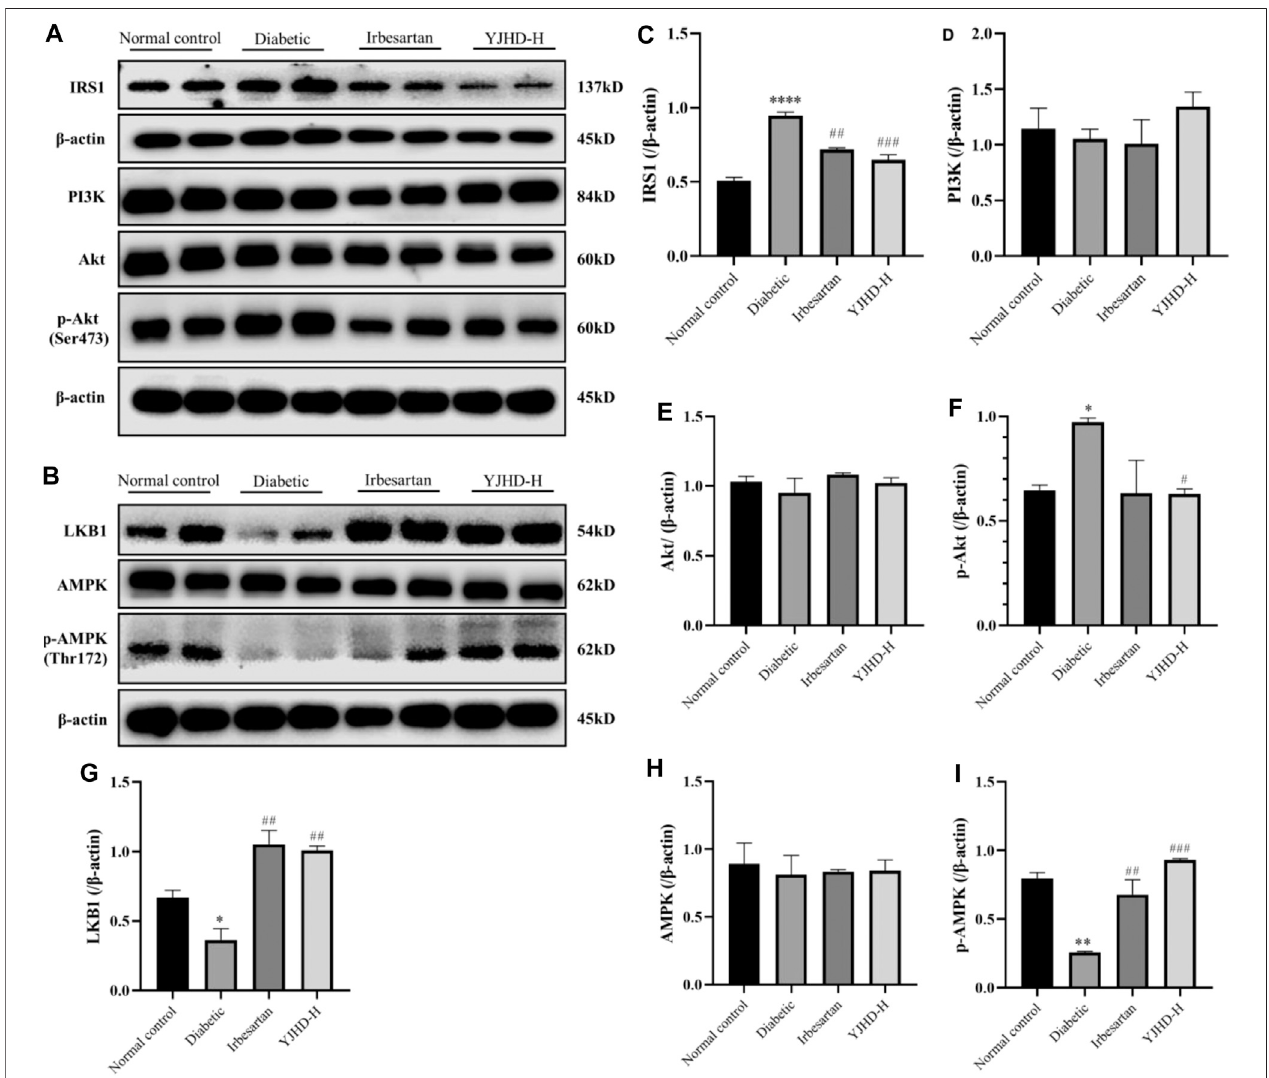
FIGURE 8 | Effects of Yiqi Jiedu Huayu decoction (YJHD) on PI3K/Akt and AMPK pathways. (A) Protein levels of IRS1, PI3K, Akt, and p-Akt were detected by western blotting. (B) Protein levels of LKB1, AMPK, and p-AMPK were detected by western blotting. (C – I) Protein concentration analysis. Data are expressed as * p < 0.05, ** p < 0.01, *** p < 0.001: compared with the normal control group, respectively; # p < 0.05 and ## p < 0.01: compared with the diabetic group